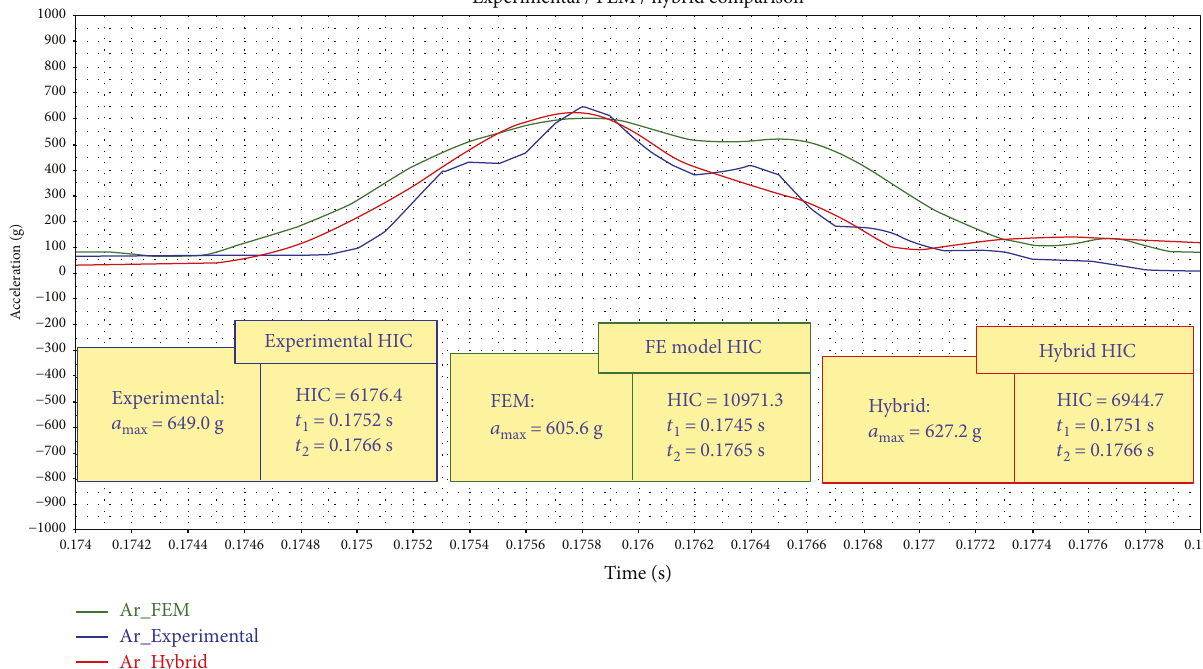
Figure 9: Head resultant